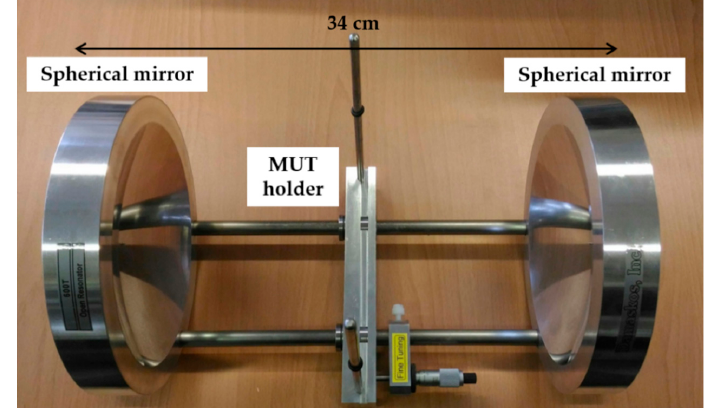
Figure 5. Damaskos model 600T open resonator.